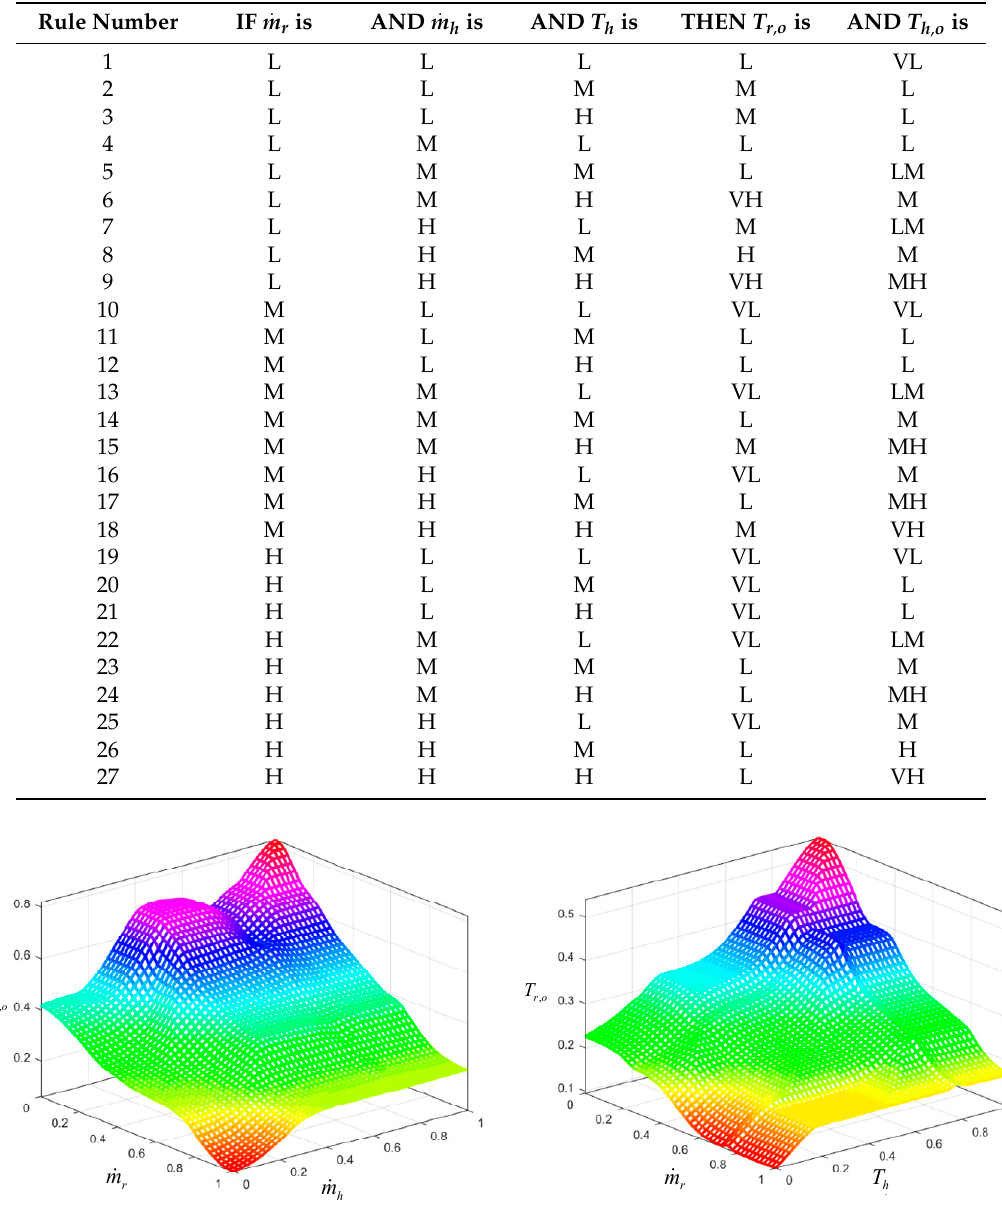
Table 4. Fuzzy rules of dynamic model of the evaporator. VL: Very Low; L: Low; M: Medium; MH: Medium to High; H: High and VH: Very High.